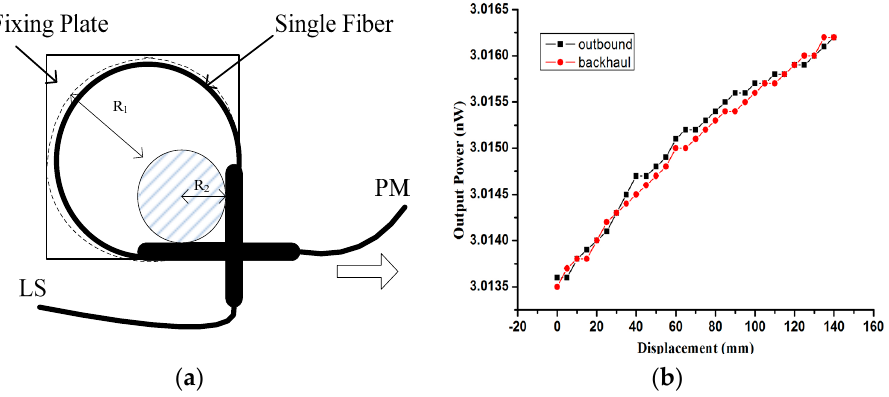
Figure 3. System of single fiber displacement sensor ( a ); Output power changes with displacement ( b ).